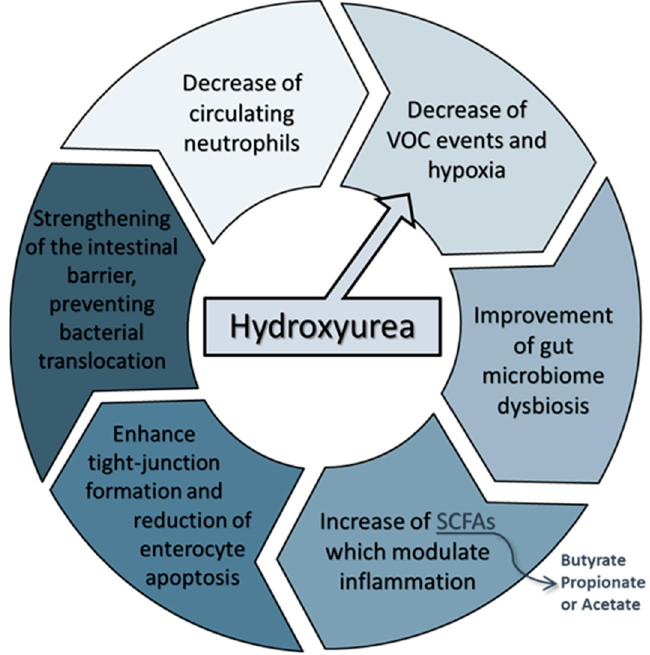
Figure 4. Illustration of the hydroxyurea impact on the gut microbiome of SCA patients.